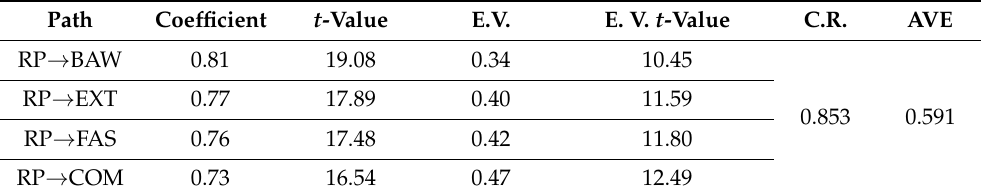
Table 4. Path coefficient goodness–of–fit index of the basic